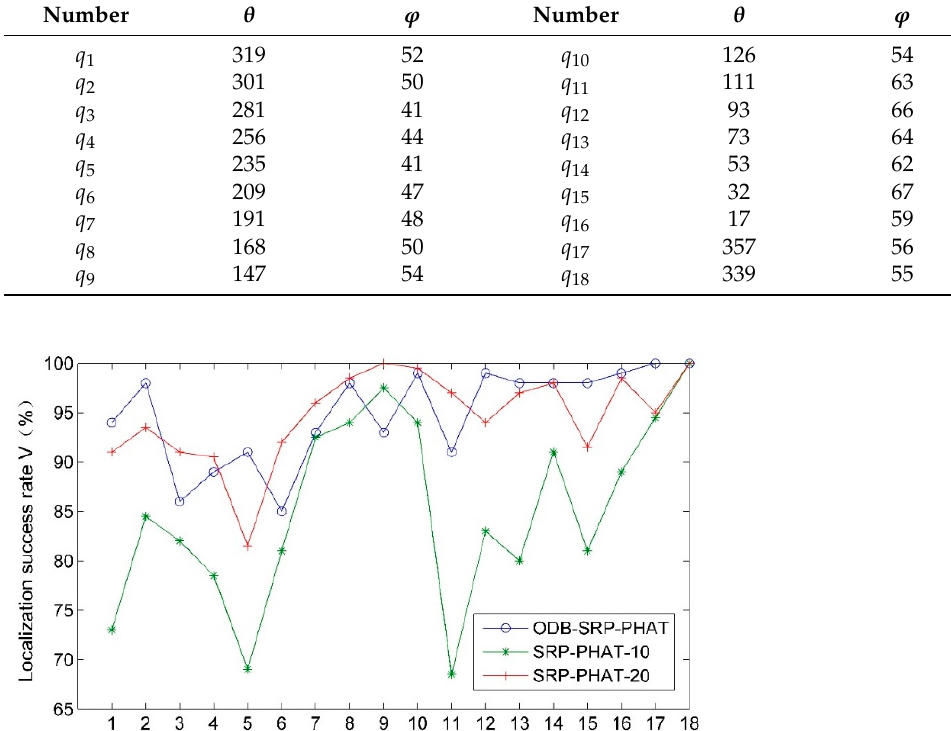
Figure 10. Clustering analysis results (18 positions). Table 4. ODB of the meeting room.